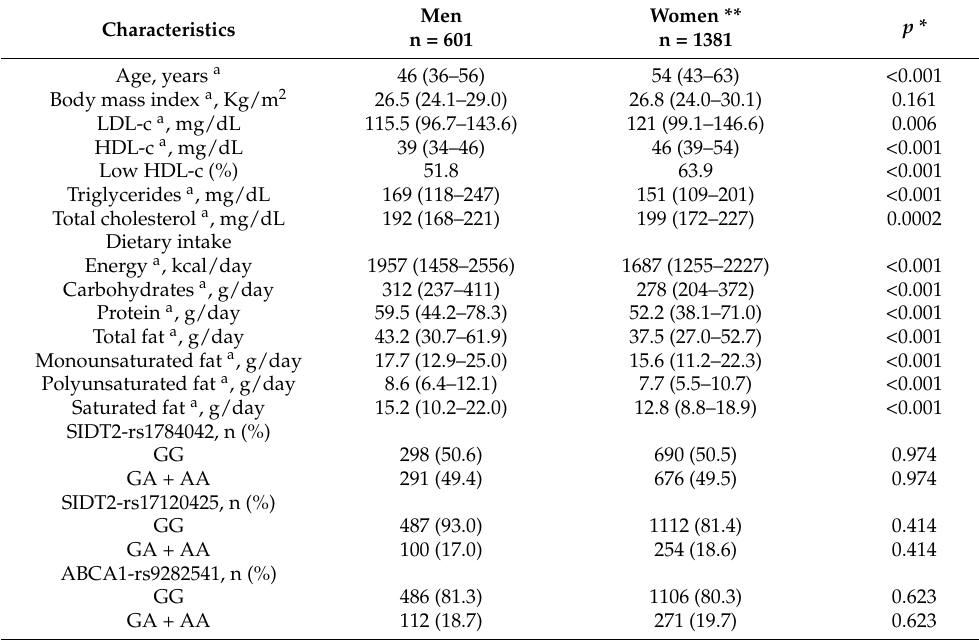
Table 1. Demographic and clinical characteristics of the Health Workers Cohort Study.